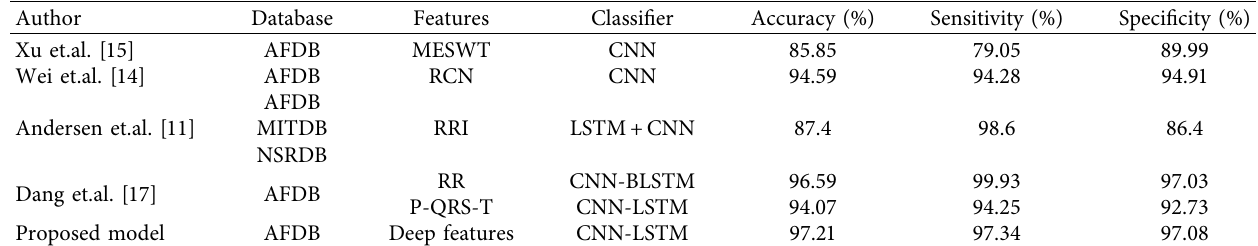
Figure 9: Confusion matrix of test set. Table 2: Comparison with previous work on the MIT-BIH AF